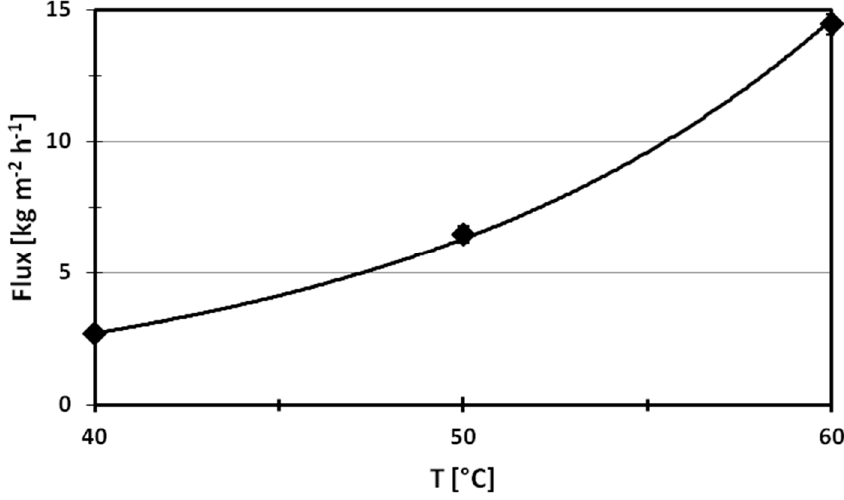
Figure 5. Effect of the feed temperature on the flux of PVDF ENM in DCMD process at a feed velocity of 0.008 m·s − 1 .